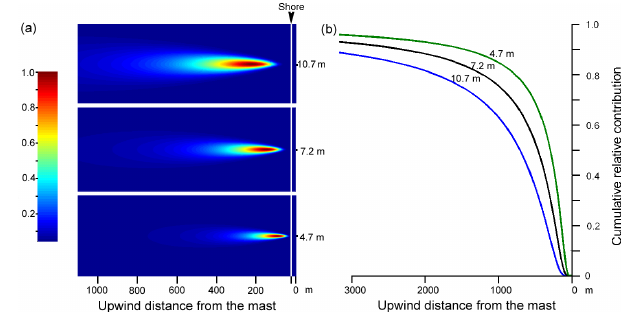
Figure 8. (a) Flux footprint areas at neutral stability seen by the CO 2 instruments at altitudes of 10.7 and 7.2m and by the ELPIs at altitudes of 7.2 and 4.7m, as recalculated in Fig. 3a. The x axis refers to the upwind distance from the instruments, and the color bar shows the relative intensity of the sea surface area to the flux. Panel (b) shows the cumulative relative contribution.